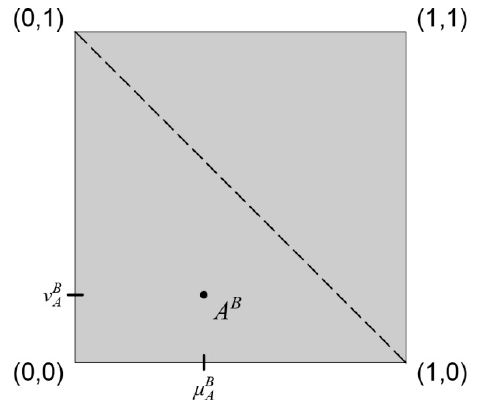
Figure 10. LBIFS-interpretational surface.